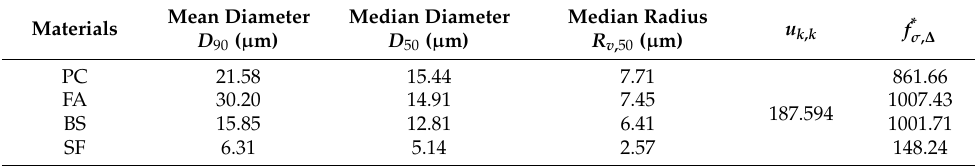
Table 4. Calculated particle size parameters for the YODEL.